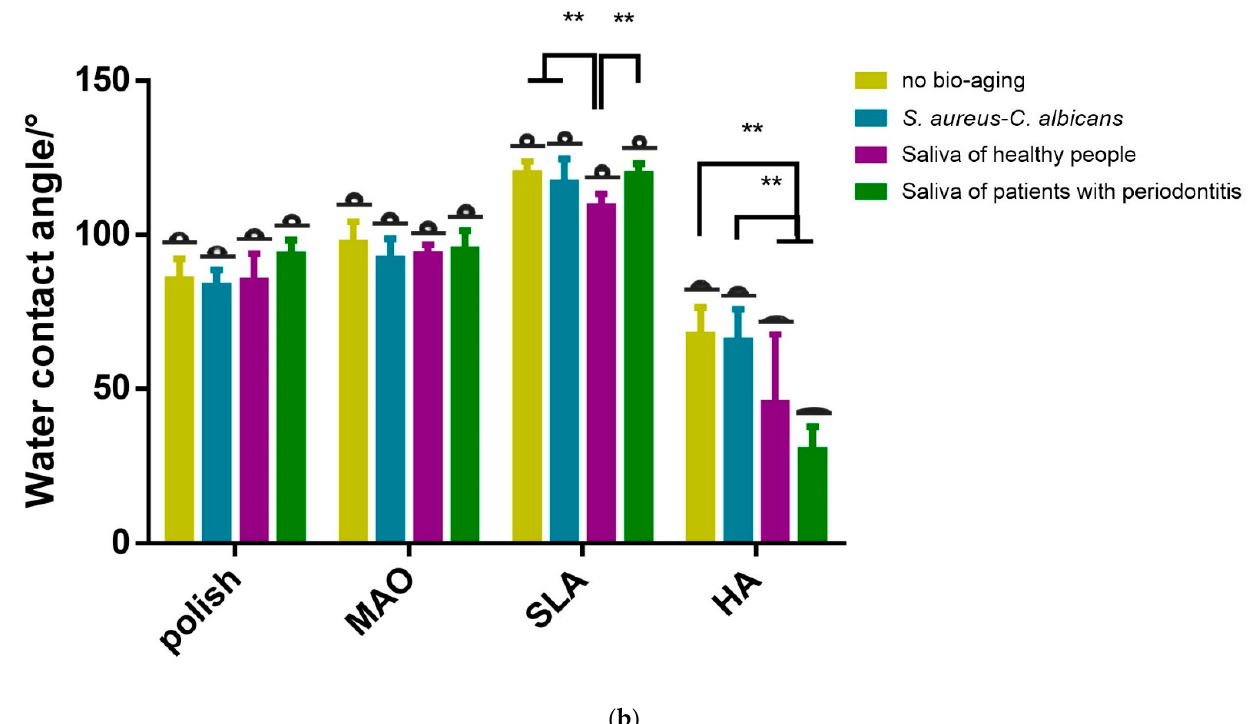
Figure 2. The surface characteristic of samples is tested. ( a ) Raman spectrum. The SLA- and polish- treated specimens showed no distinctive peaks so the results are not shown here; ( b ) water contact angle. The picture of the water droplet on the sample was placed above the bar. n = 5 (** p < 0.01). The wettability of the samples was measured by the water contact angle (Figure